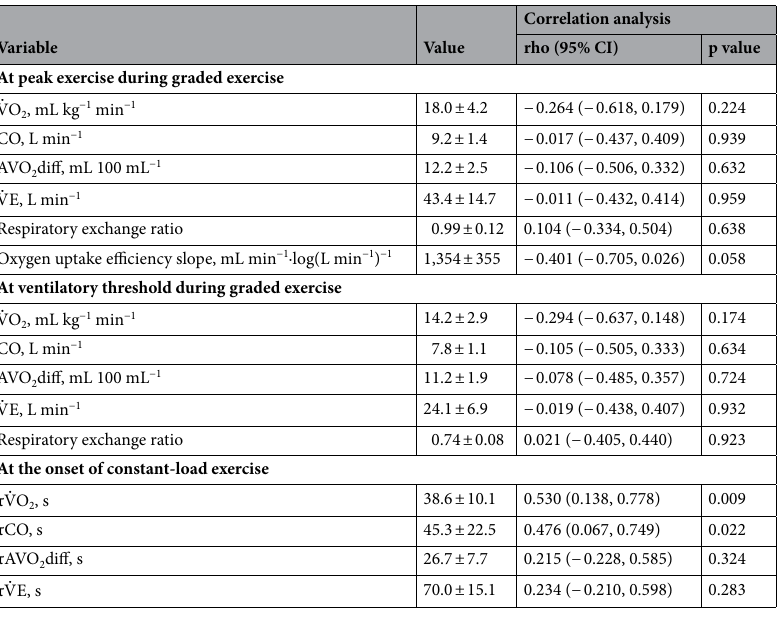
Table 2. Correlations between the Fatigue Severity Scale score and cardiorespiratory variables during a symptom-limited graded exercise test and a submaximal constant-load exercise test. Values are presented as mean ± standard deviation. Rho Spearman’s rank correlation coefficient, output, AVO 2 diff arterial-venous oxygen difference,